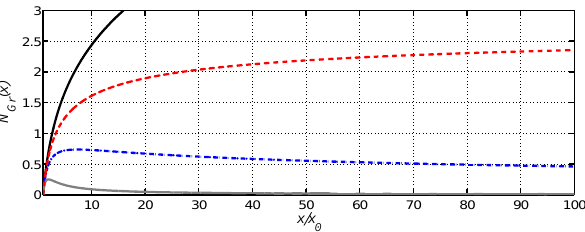
Fig. 12. Wave amplitude variations versus distance (Eq. 50) for γ =1 (black solid line), γ = 4 / 3 (red dashed line), γ = 2 (blue dash- dotted line), γ = 4 (green dotted line).